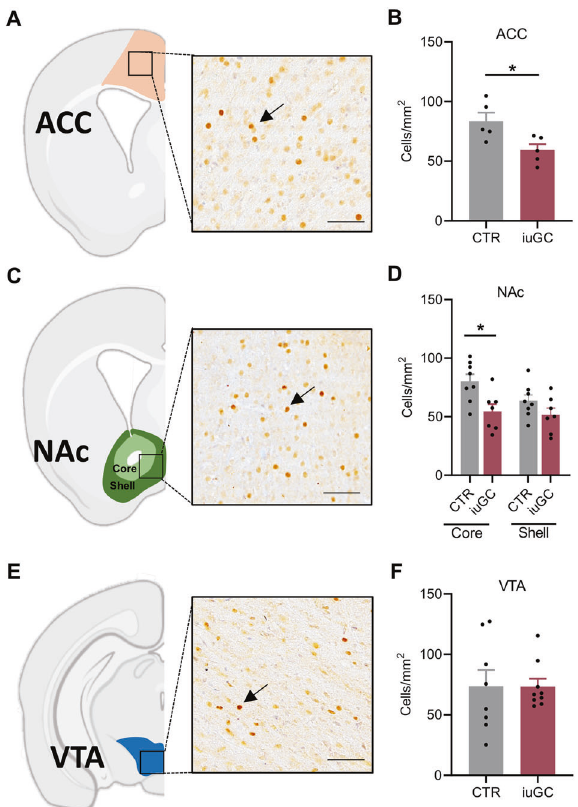
Fig. 2 Neuronal recruitment impairment in the ACC and NAc in an effort-discounting task caused by iuGC exposure. A Representative immunohistochemistry of c-fos in the ACC ( n CTR = 5, n iuGC = 6). B Effort-discounting task recruited ACC of both groups but at different extents, with the activation being signi fi cantly lower in iuGC rats. C Representative immunohistochemistry of c-fos in the NAc core ( n CTR = 8, n iuGC = 7) and shell ( n CTR = 8, n iuGC = 7). D The NAc core of iuGC rats presented signi fi cantly less c-fos + neurons than CTR rats upon task performance, but not E the NAc shell. F Representative immunohistochemistry of c-fos in the VTA ( n CTR = 8, n iuGC = 8). G No differences in the number of c-fos + neurons were observed in the VTA. Error bars denote SEM. * p ≤ 0.05. Scale bar = 25 μ